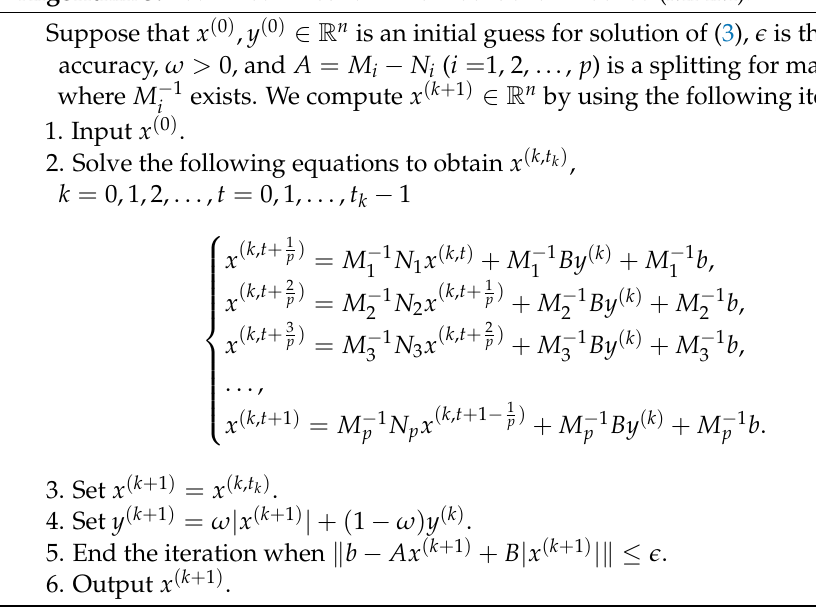
Algorithm 3: Modified Picard-Like Iteration Method